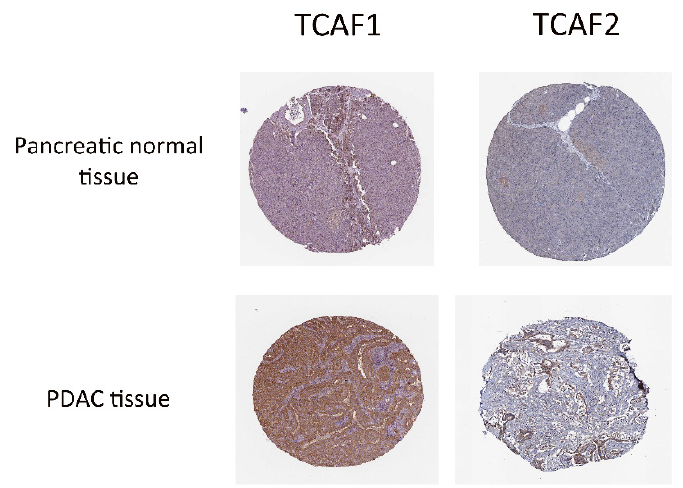
Figure 8. Representative immunohistochemistry images of TCAF1 and TCAF2 from PDAC tissues extracted from the HAP database.